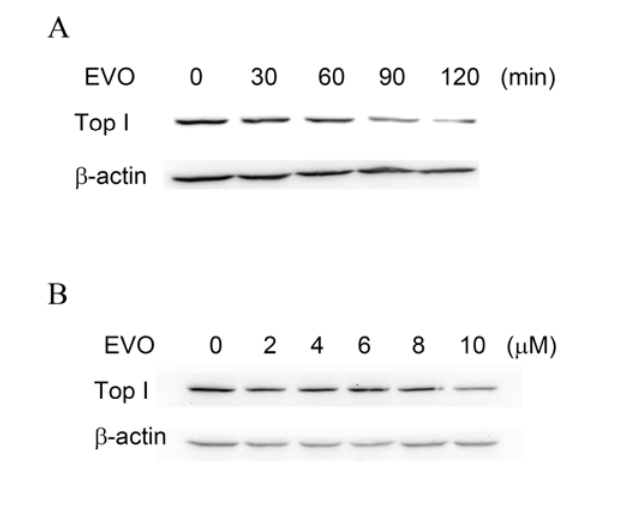
Figure 3. Topoisomerase I (TopI) depletion by evodiamine (EVO) in MCF-7 cells. (A) MCF-7 cells were treated with EVO (10 μ M) for 0~120 min. (B) MCF-7 cells were treated with various concentrations of EVO (0~10 μ M) for 60 min. Protein levels of TopI were examined by immunoblotting. β -Actin with constant expression was used as the internal